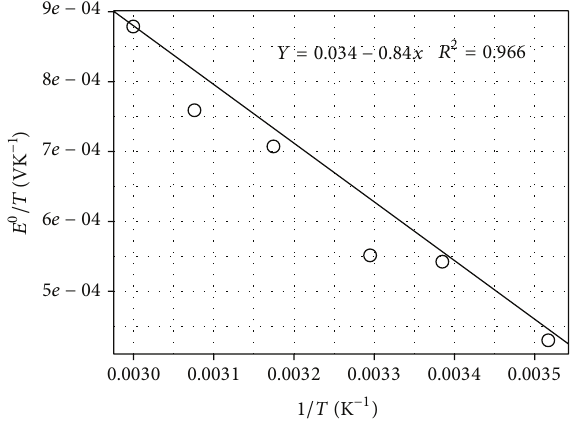
Figure 7: Gibbs-Helmholtz plot for Mb/PMMA- b -PDMAEMA in phosphate buffer.